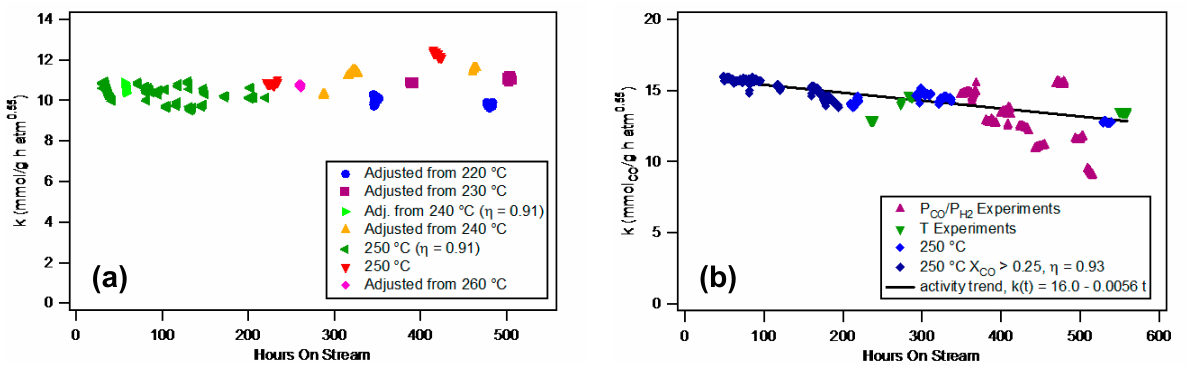
Figure 11. Experimental rate constant values at 250 °C as a function of time-on-stream for ( a ) 1UH and ( b ) 2UH catalysts. Legends represent data converted from different reaction temperatures.